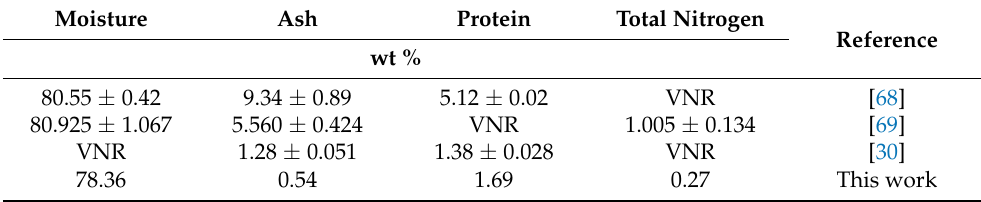
Table 5. Average proximate analysis for fresh CP from cacao fruit samples of various origins.